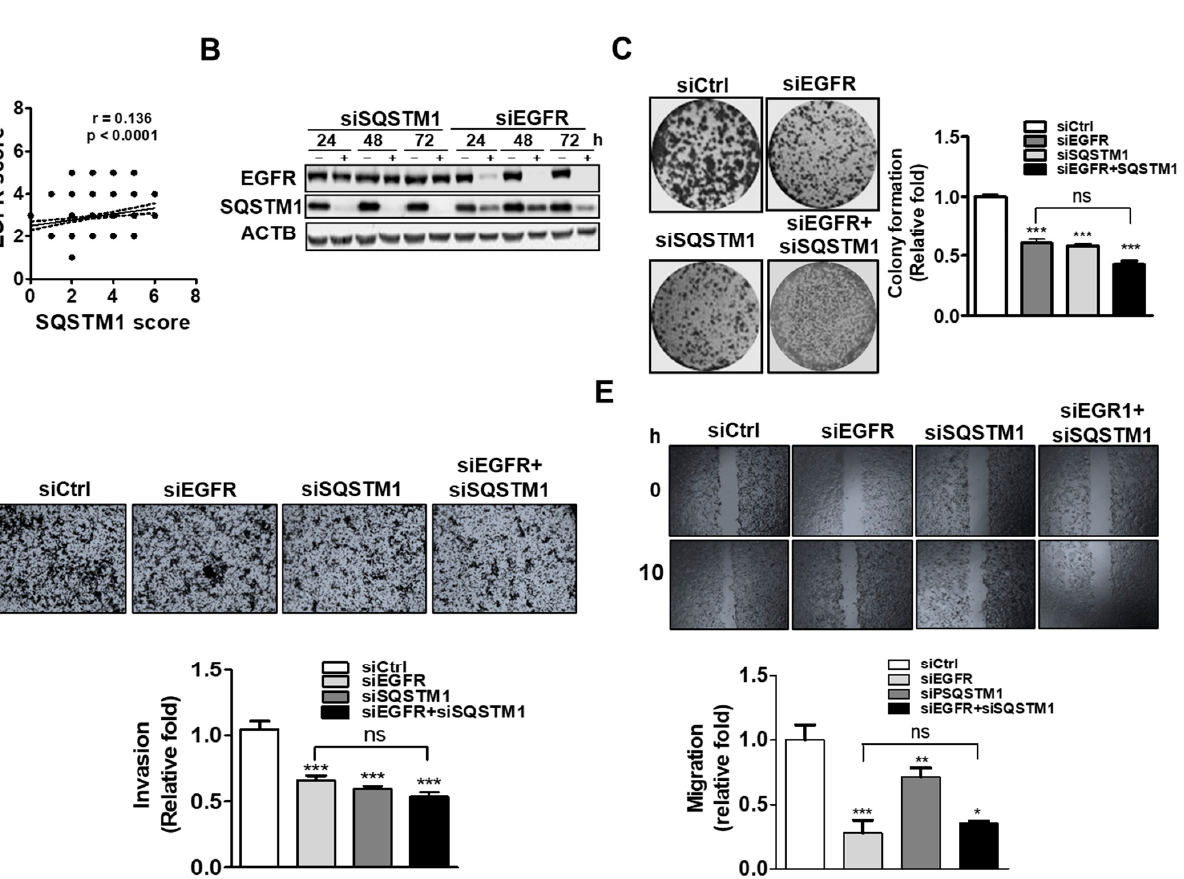
Figure 1. Correlation and regulation between EGFR and SQSTM1 in OSCC. ( A ) Correlation between SQSTM1 and EGFR expression in tumor tissues of OSCC patients. ( B ) Protein expression levels of EGFR and SQSTM1 in SAS cells silenced by scrambled siRNA (( − ), siCtrl), SQSTM1 siRNA, or EGFR siRNA (+) for 24–72 h with Western blotting (ACTB: